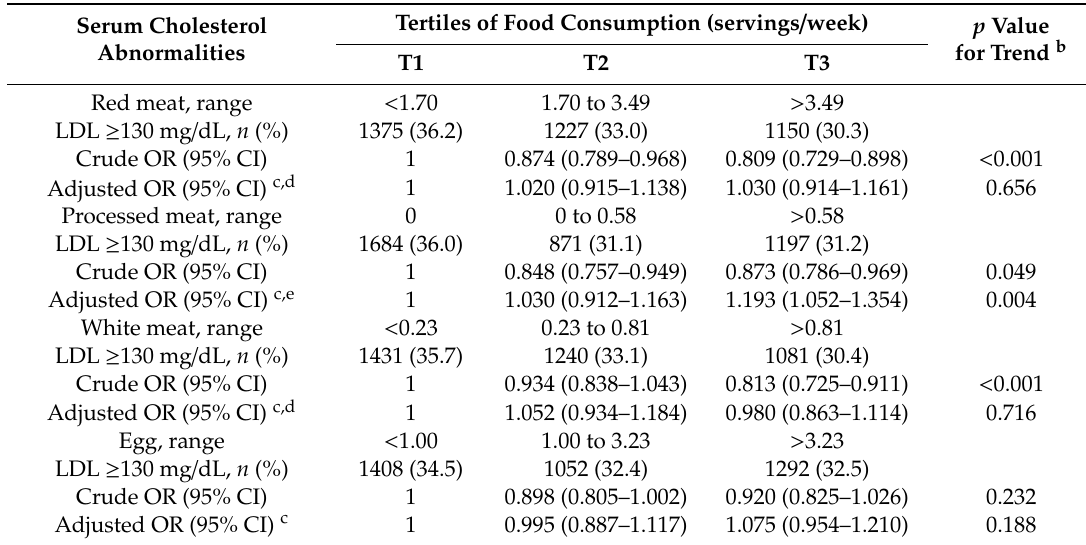
Table 4. Associations between consumption of food sources of dietary cholesterol and the risk for abnormalities in low-density lipoprotein-cholesterol level a